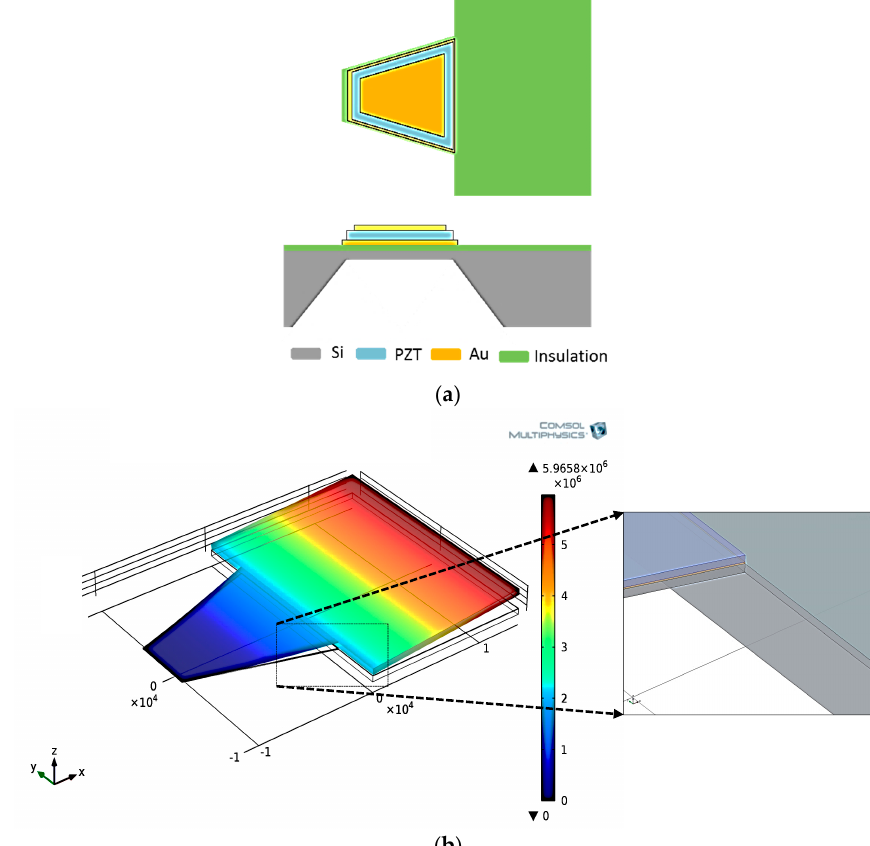
Figure 1. ( a ) Si/PZT cantilever harvester structure (up: top view; down: side view); ( b ) 3D-mode shape of the harvester structure according to ( a ), namely the 1st mode at 50 Hz resonance